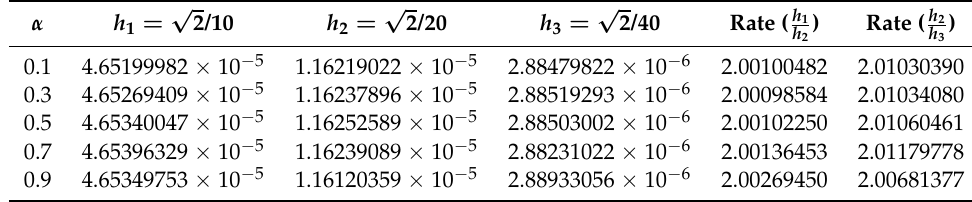
(cid:107) u ( t n ) − u n n